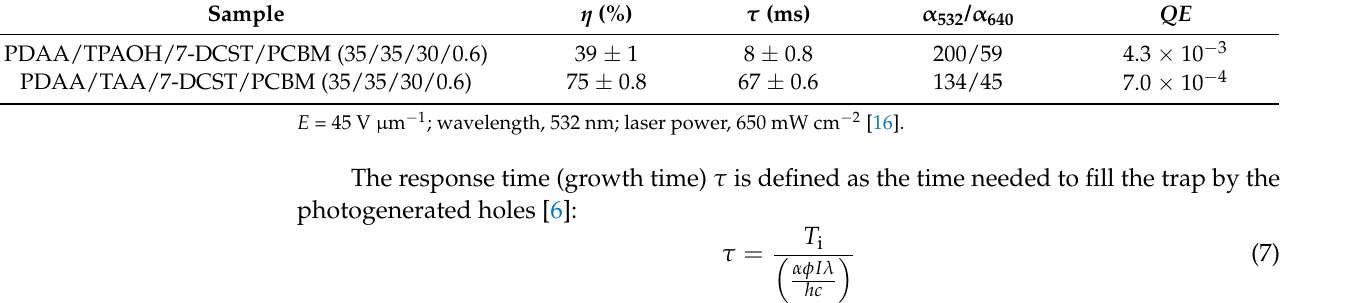
Table 1. Summary of the photorefractive parameters of diffraction efficiency, response time, the absorption coefficient, and the evaluated QE for different plasticizers.